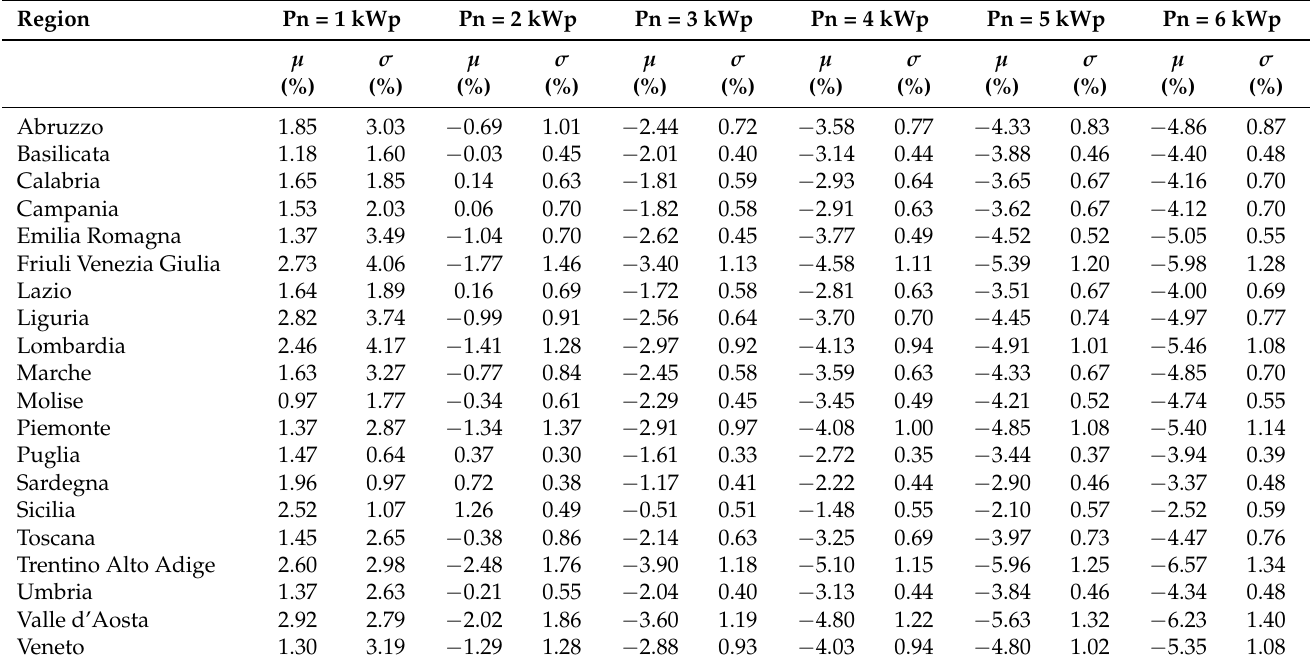
Table 7. Internal Rate of Return (IRR) E L = 2700 kWh without battery.